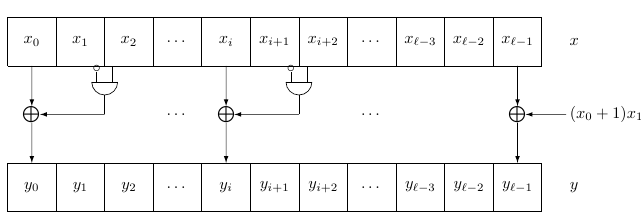
Figure 1: χ ‘ with input x and output y